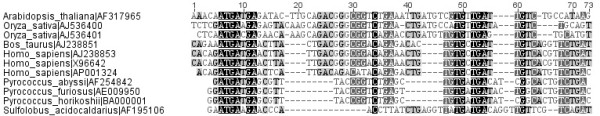
Alignment of eukaryote SNORD43 with archaeal sR12 sequences from Pyrococcus and Sulfolobus indicates detectable sequence similarity, suggestive of common ancestry. The alignment does not yield a conserved secondary structure, and therefore the possibility of convergence cannot be ruled out.